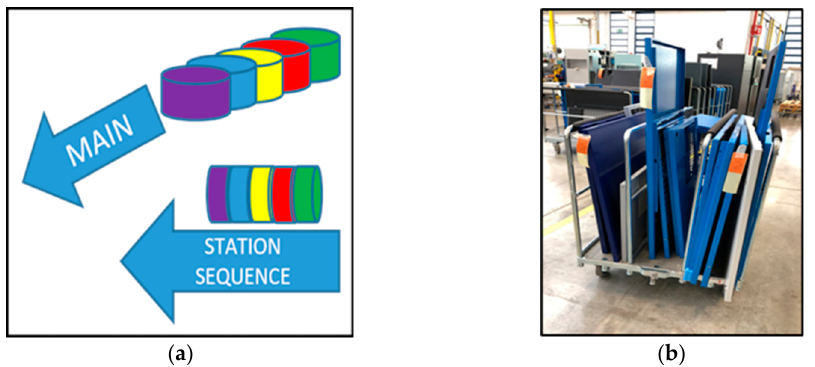
Figure 1. ( a ) A scheme of how the station-sequence policy works; ( b ) An industrial example of station-sequence application.